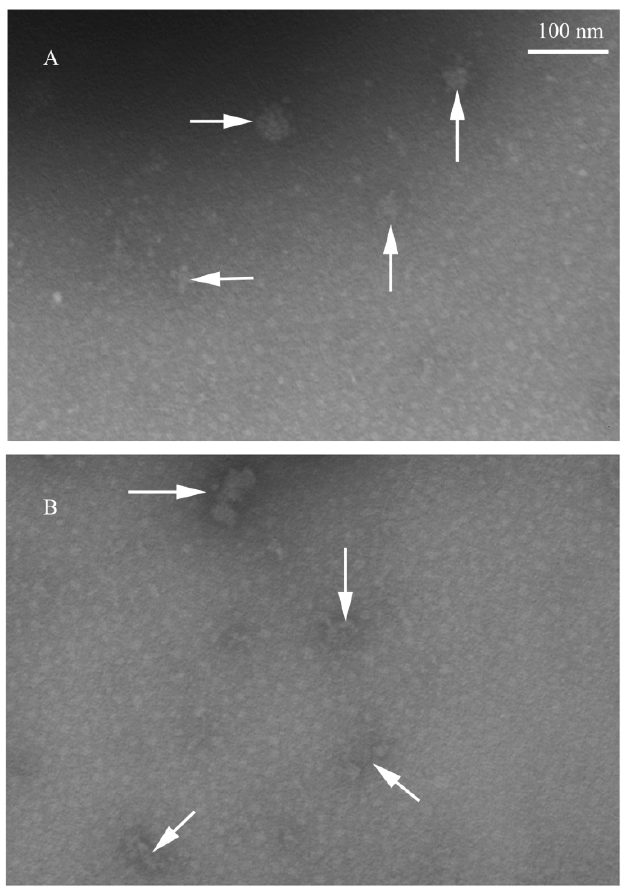
Figure 5. Transmission electron microscopic (TEM) images of MNV-1 in the absence or presence of HP. MNV-1 control ( A ) and MNV-1 treated with 250 μ g/mL HP ( B ). Scale bars, 100 nm.